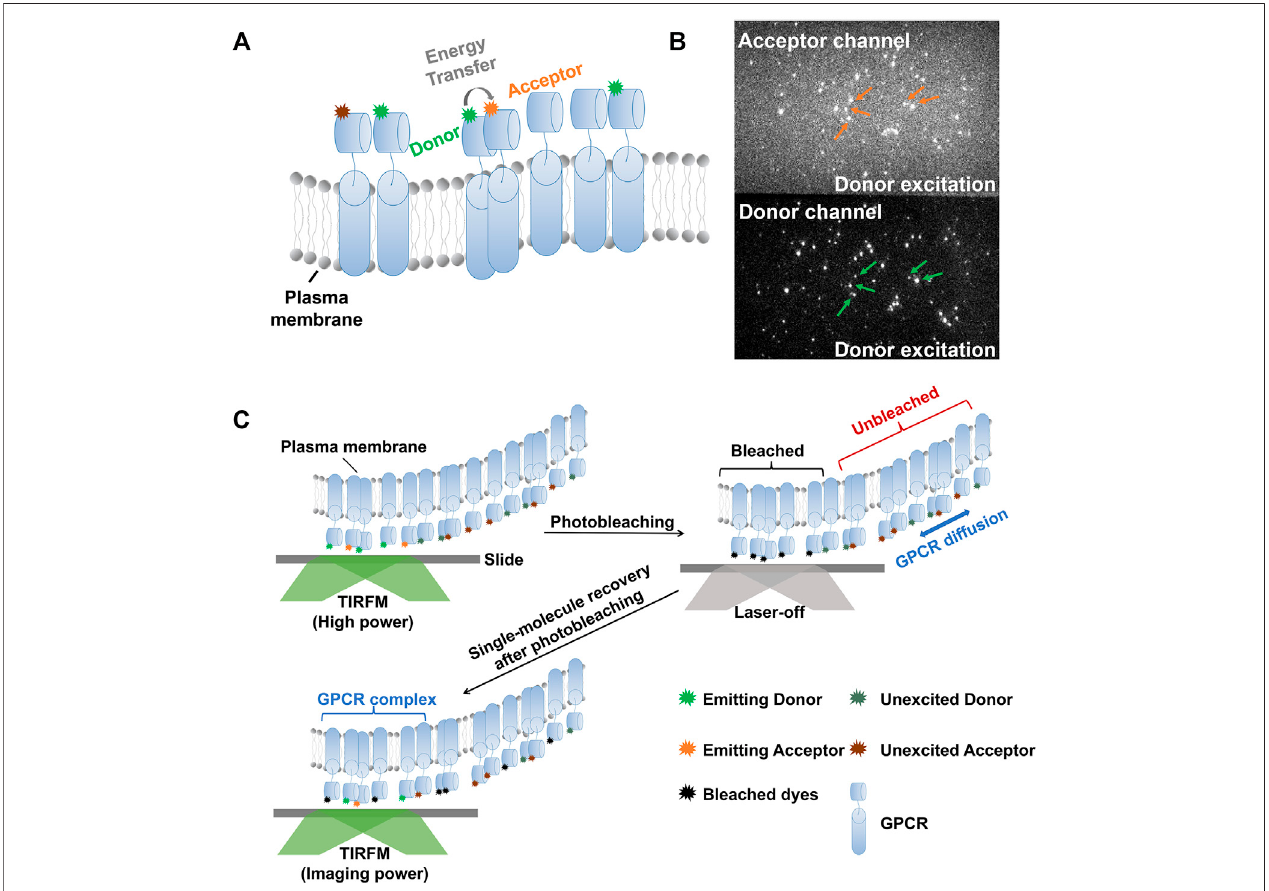
FIGURE 3 | Schematics of smFRET combined with FRAP to study the dimerization of membrane proteins. (A) Label strategy for smFRET experiment to study dimerizationofmembraneproteins.Whenthemembraneproteins(useGPCRasexample,denotedbylightbulecylinders)labeledwithdifferent fl uorophoresdiffusevery close toeach other, the acceptor will emit photons (orange stars) with energy transferred from donor (green star) upon donor excitation conditions, or else, the acceptor remain silent (dark orange stars). (B) Representative image of smFRET. The orange and green arrows denote the positions where both photons emitted by donor and acceptor can be collected, indicating FRET events. (C) Schematic of the smFRET-FRAP approach. Firstly, the active donor- and acceptor-labeled proteins in the TIRF-illumination fi eld are selectively photobleached with high laser power. Both the donor and acceptor lasers are turn-on to make sure the thorough photobleaching. Then,unbleachedacceptor-anddonor-labeledreceptorssubsequentlydiffuseintotheTIRF-illumination fi eldfromoutside.Turnontheimaginglaseri.e.donorexcitation laser at lower power than bleaching one, and the dimerization can be monitored by FRET at single-molecule